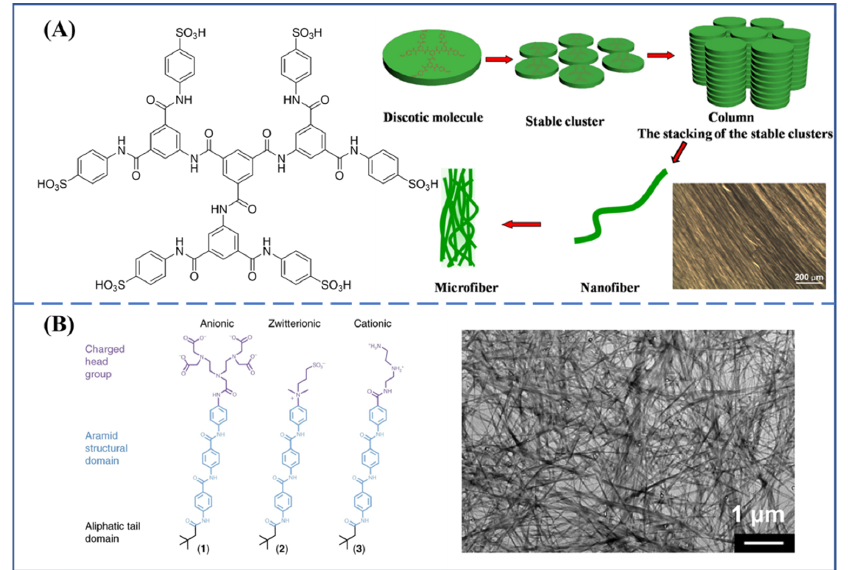
Figure 4. ( A ) The self-assembly behavior of discotic aromatic aramid molecule [37]. Copyright 2017 Elsevier B.V.; ( B ) The aramid molecule containing a charged head group and an aliphatic tail spontaneously self-assemble into nanoribbons in water [38]. Copyright 2021 Springer Nature (Berlin/Heidelberg, Germany).